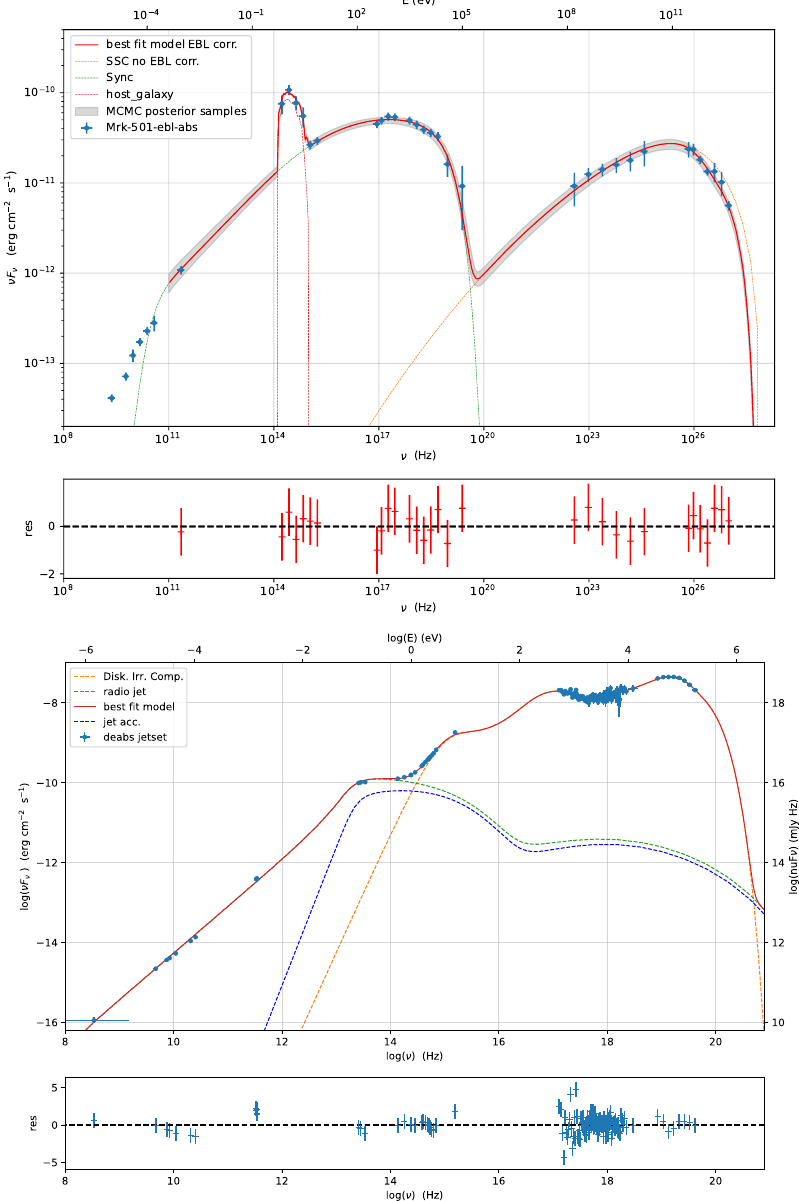
Figure 5. Fitting MWL SEDs with Jetset. Top panel : Best fit of the Mrk 501 SED considering synchrotron and SSC emission, the galaxy template, and the absorption on the EBL. The gray band illustrates the MCMC model posterior samples. Figure adapted from the Jetset documentation. Bottom panel : Best-fit model of the MWL emission of the microquasars MAXI J1820+070. The dashed lines represent the individual components; the red line, their sum. Figure from